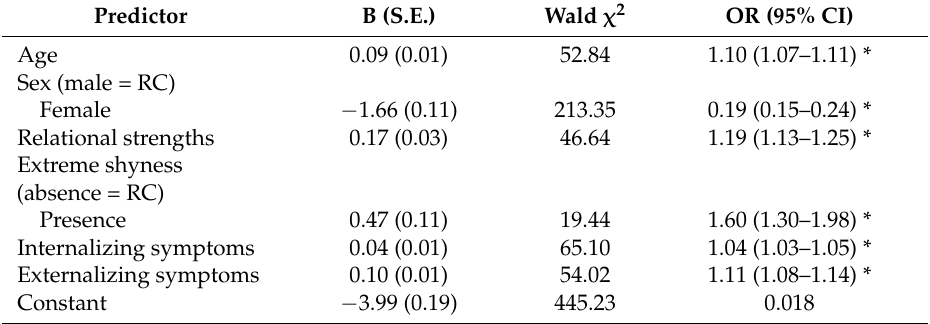
Table 2. Regression analysis: Problematic Video gaming (PVG) as the dependent variable.